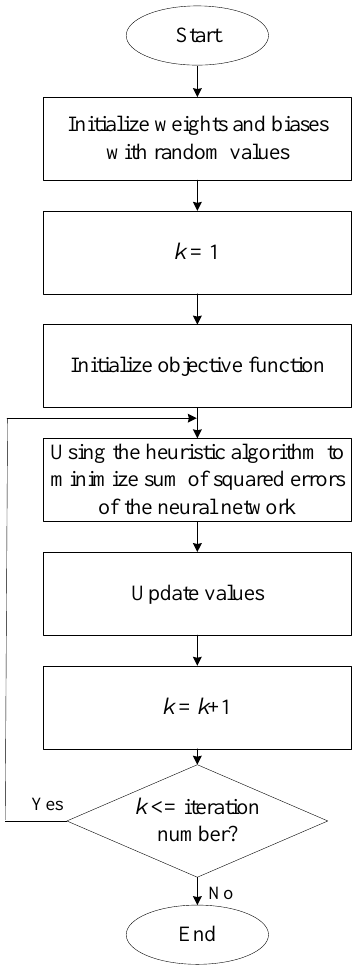
Figure 6. Using heuristic algorithm to train neural networks.